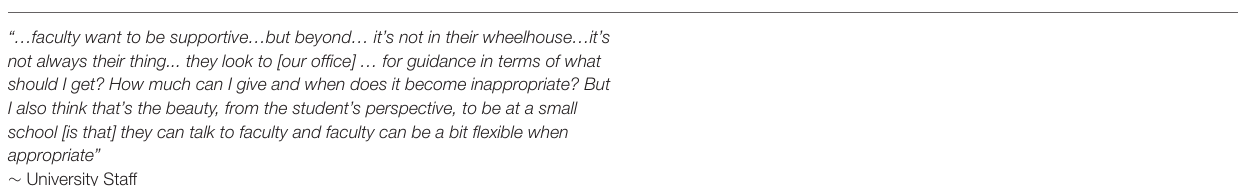
TABLE 9 | Preferred supports: illustrative comments from study participants. “…it could be helpful to have some, maybe help with the kinds of tools that we have on our website that you can actually use for like planning and stuff, like information about the degree evaluations and the course catalogs and such. I think those are super useful resources…What if [there was a] tool on the degree evaluation where you can plug in, I’m doing this now? What if I added this minor and did this, how would that look? And I think some people don’t necessarily know about all of that stuff that we have access to. It could maybe be helpful to have little sessions or courses to remind people that we have these things at our disposal and show them how to work with them and use them.” ∼ Public Health Student